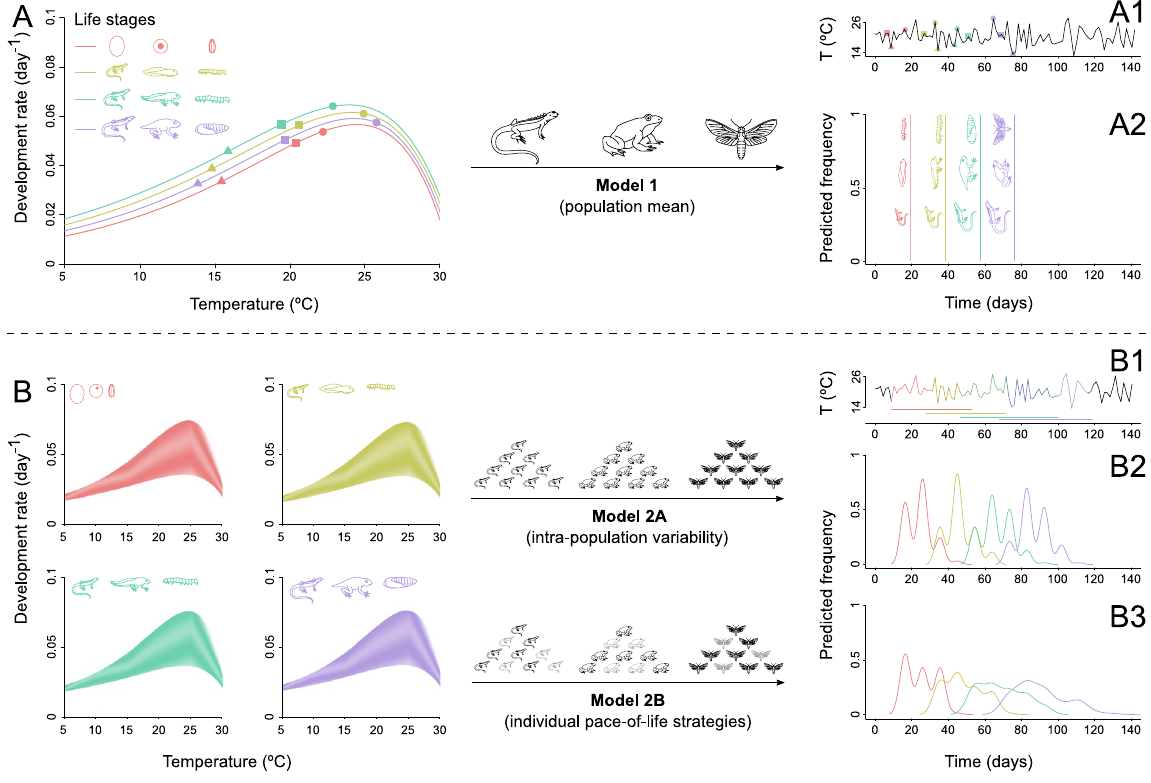
Figure 1. Model construction and theoretical predictions of the phenology of an ectotherm species (e.g., lizard, frog or moth) at different life stages (e.g., egg, pre-larva, larva and pupa) based on simulated thermal performance data and temperature time-series experienced over the life cycle. Model 1 fits a mean thermal performance curve (TPC) between temperature and species’ development rates for the four life stages ( A ), and then applies the TPC over a temperature time series (A1; circles, squares and triangles illustrate the correspondence between the TPC and the temperature time-series) to obtain the phenology of the four life stages (A2). Model 2A constructs a thermal performance probability (TPP) surface for the four life stages ( B ) and then applies the TPP over the same temperature time-series (B1) to obtain the population distribution of the phenology over time (B2), resulting in overlapping life stages over time (B1,B2). Model 2B applies the same TPP than Model 2A ( B ) over the temperature time series (B1) but takes into account slow-fast strategies in development among individuals (see text for details) to obtain population distribution of the phenology over time (B3). Note that species are represented for illustrative purpose and do not depict realistic development